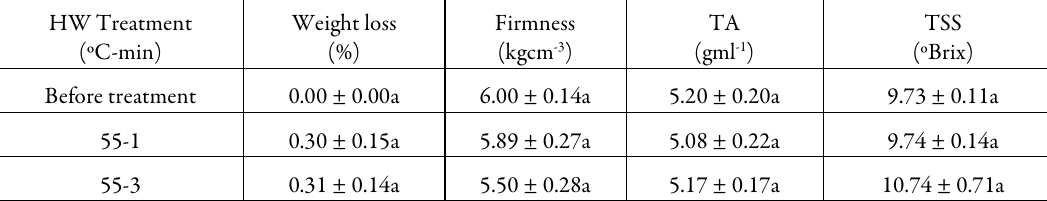
Table 4. Internal quality parameters of mango fruits treated at the most effective hot water (HW) treatments HW Treatment Weight loss Firmness TA TSS (ºC-min) (%) (kgcm -3 ) (gml -1 ) (ºBrix) Before treatment 0.00 ± 0.00a 6.00 ± 0.14a 5.20 ± 0.20a 9.73 ± 0.11a 55-1 0.30 ± 0.15a 5.89 ± 0.27a 5.08 ± 0.22a 9.74 ± 0.14a 55-3 0.31 ± 0.14a 5.50 ± 0.28a 5.17 ± 0.17a 10.74 ±